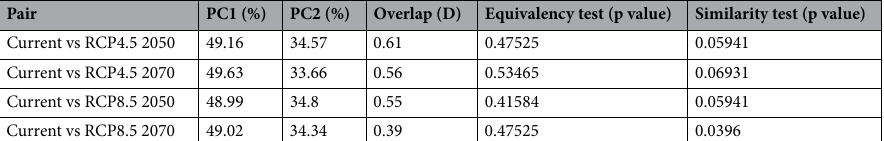
Table 7. Niche comparisons and first two principal components between current and future projected distribution of Dactylorhiza hatagirea .